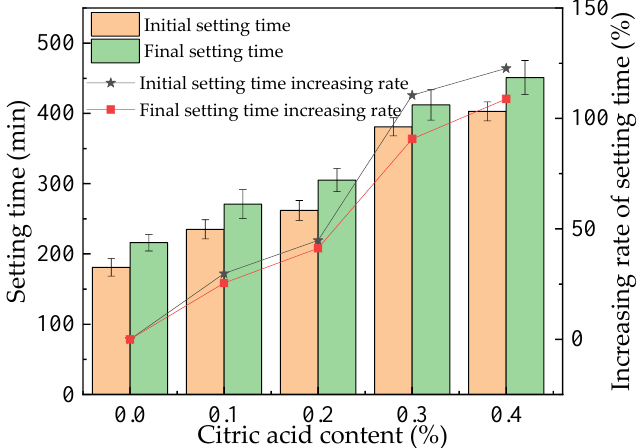
Figure 2. The setting time of the fresh MOS paste.